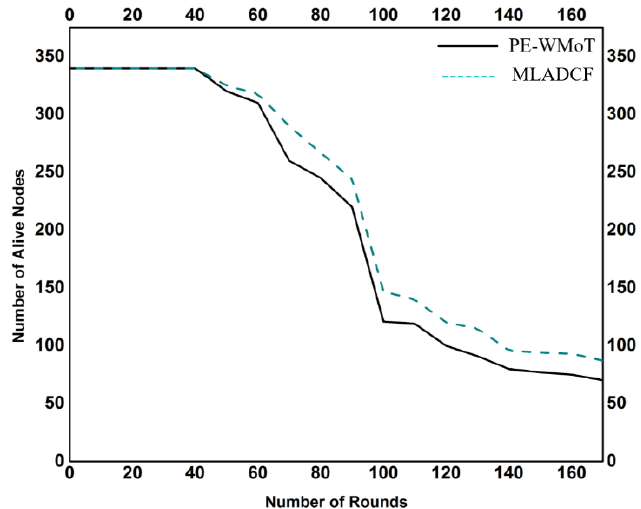
Figure 10. No. of Rounds Vs. No. of Alive Nodes.